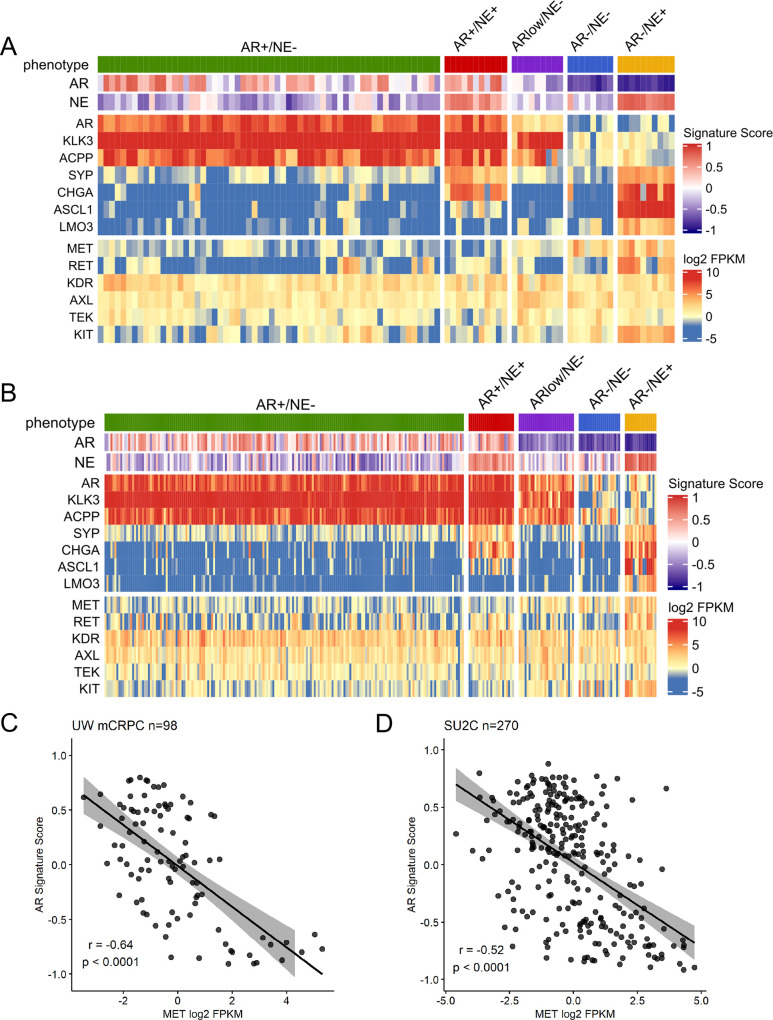
Metastatic SCNPC upregulates MET and RET.Whole transcriptome RNA-Seq heatmaps of (A) UW rapid autopsy cohort (n = 98) and (B) SU2C cohort (n = 270) depicting AR-associated genes (AR, KLK3 and ACPP), NE-associated genes (SYP, CHGA, ASCL1 and LMO3), targets of cabozantinib (MET, RET, VEGFR2/KDR, AXL, TEK, KIT), and AR and NE activity scores. Results are expressed as log2 FPKM (transcripts) or as GSVA scores (activities) and are colored according to scale. Correlation analysis of AR activity scores (GSVA) and MET transcript expression (log2 FPKM) in (C) UW and (D) SU2C cohorts.